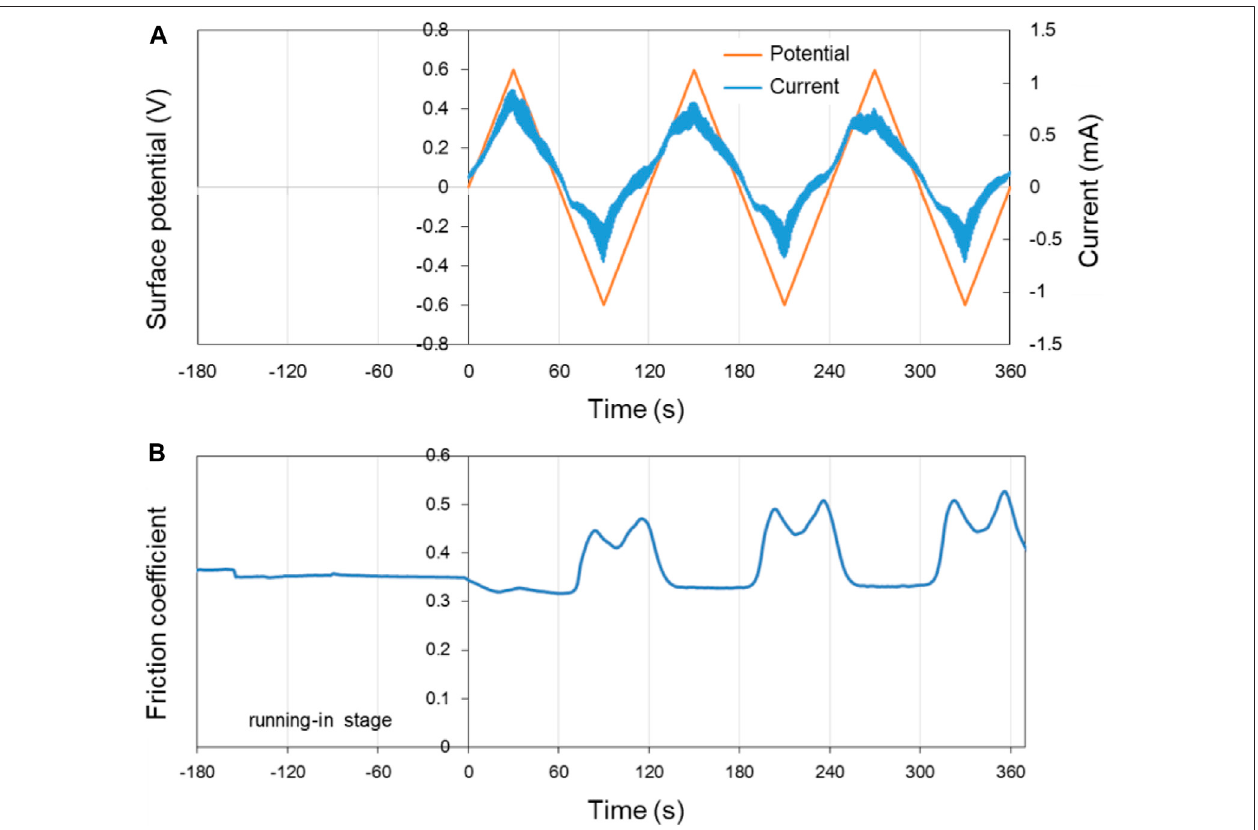
FIGURE 6 | Potential-controlled friction results of the Cu plate vs. ZrO 2 ball with pure H 2 O as lubricant, with the test range of surface potential ± 0.6 V. (A) The change of surface potential and current of Cu plate with time and (B) the variation curve of friction coef fi cient with time under the applied surface potentials in (A)